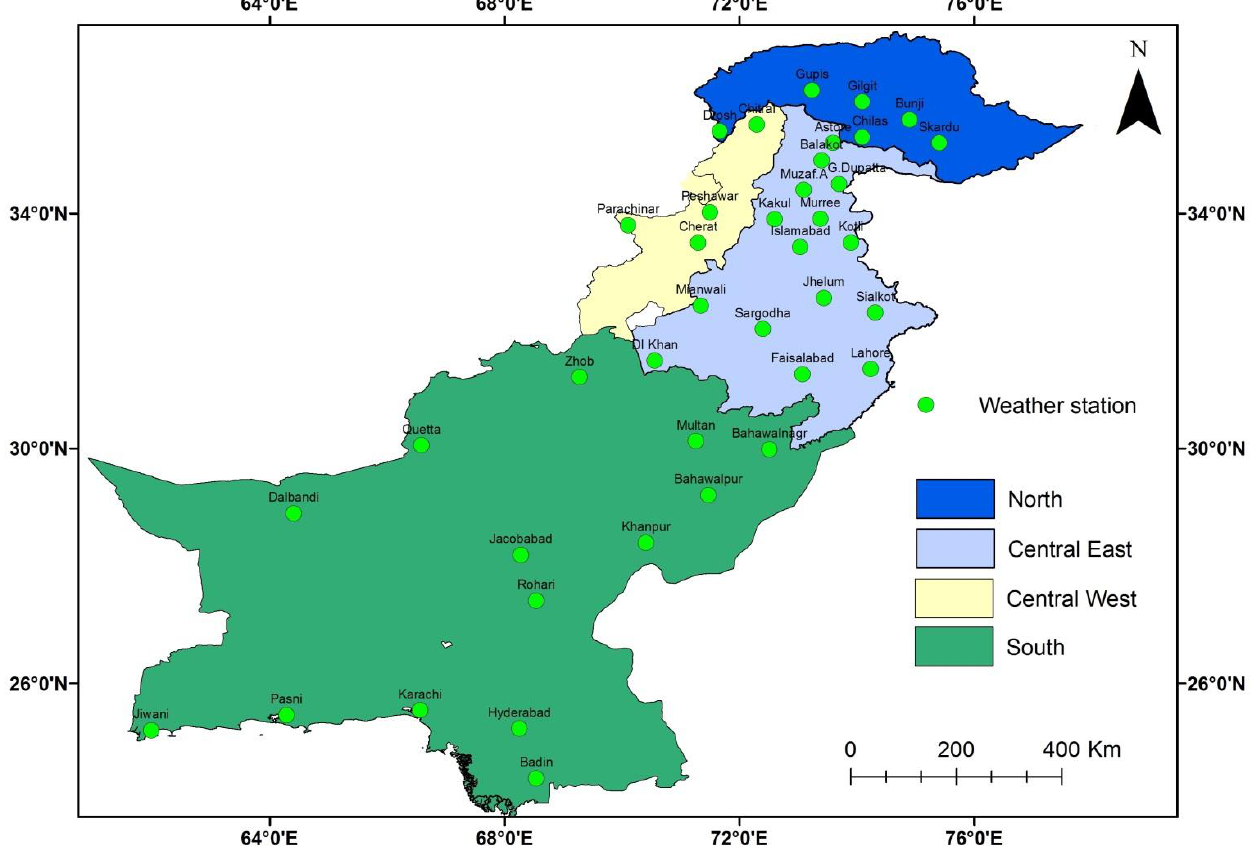
Figure 1. Network of climatic stations installed by Pakistan Meteorological Department (PMD)